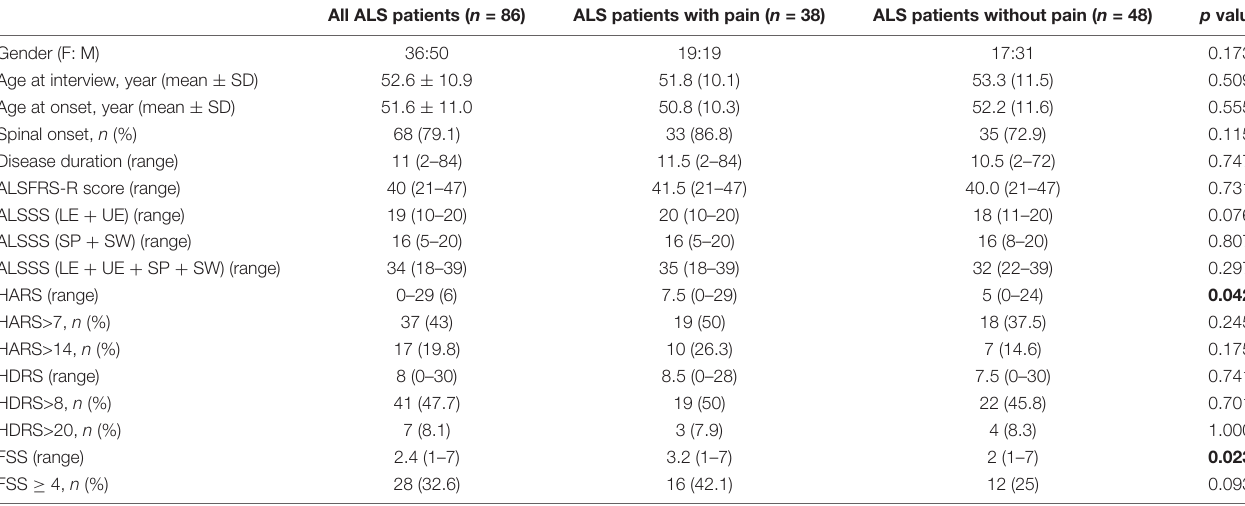
TABLE 1 | Demographic and clinical characteristics of amyotrophic lateral sclerosis (ALS) patients with pain or without pain. All ALS patients ( n = 86) ALS patients with pain ( n = 38) ALS patients without pain ( n = 48)